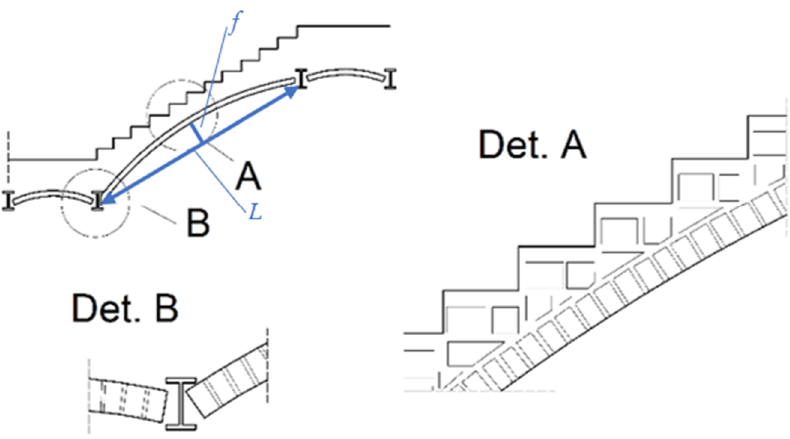
Figure 1. Masonry stairs with segmental vault and arched staircase slab, based on [1].